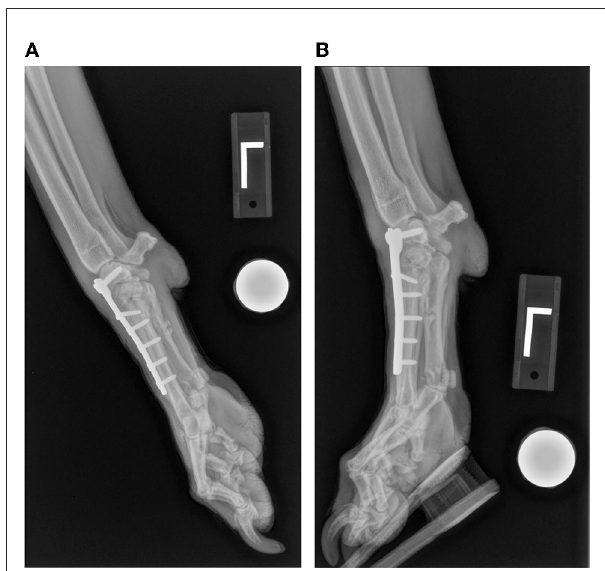
FIGURE1 Post-operative partial carpal arthrodesis radiographic views of the left carpus. (A) Lateral view of the left carpus in neutral position showing appropriate plate and screw placement. (B) Lateral view of the left carpus in hyperextension showing implant interference between the proximal aspect of the plate and the